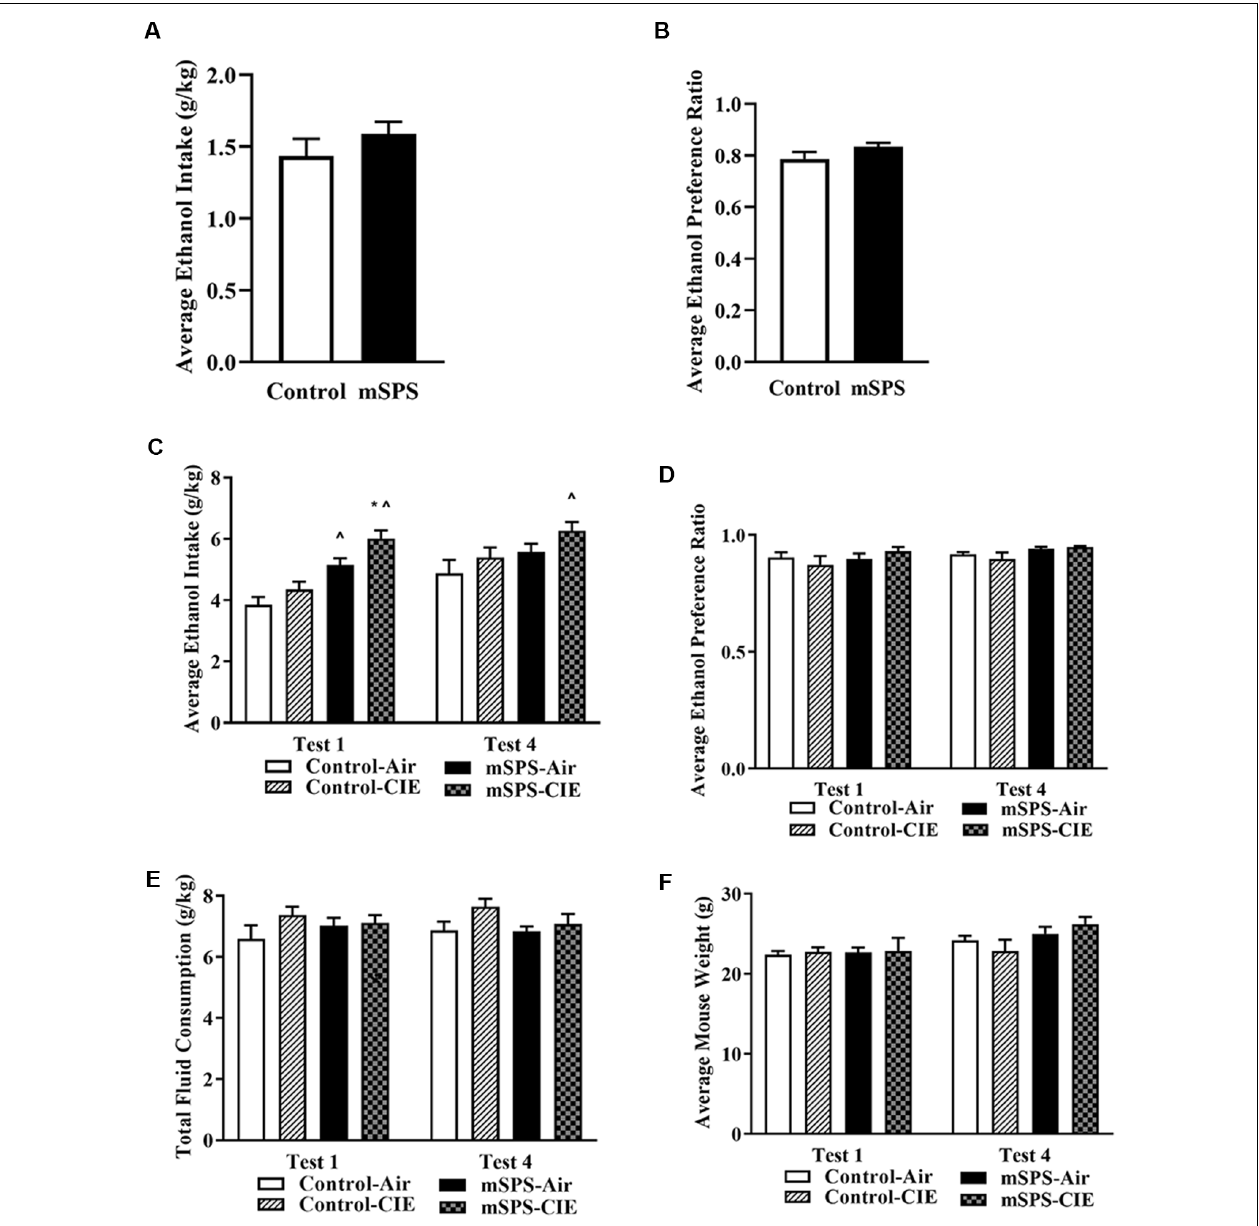
FIGURE 2 | Average of Pre-CIE (A) ethanol intake and (B) ethanol preference on the 8th day after 7-day of incubation. A student’s two-tailed t -test revealed no significant impact on ethanol consumption and preference after mSPS ( n = 14). However, a three-way ANOVA with repeated measures and post hoc Fisher-LSD test showed the results in (C) that vapor-induced ethanol intake was significantly increased in mSPS-CIE ( n = 5) compared to Control-Air ( n = 5; ∧ p < 0.05) and Control-CIE mice ( n = 4; * p < 0.05) in the 1st and 4th Post-CIE ethanol intake test sessions (Test 1 and 4). Mice exposed to mSPS and air control (mSPS-Air: n = 4) showed increased ethanol consumption in the 1st post-CIE ethanol intake session (Test 1; ∧ p < 0.05) compared to Control-Air mice, but not in subsequent Post-CIE ethanol intake test sessions. The results in (D) showed no significant impact on ethanol preference among groups in either test session. A three-way ANOVA with repeated measures showed that neither the (E) average total fluid consumption among groups nor the (F) mouse body weights were affected in Test 1 and 4. Data are mean ±